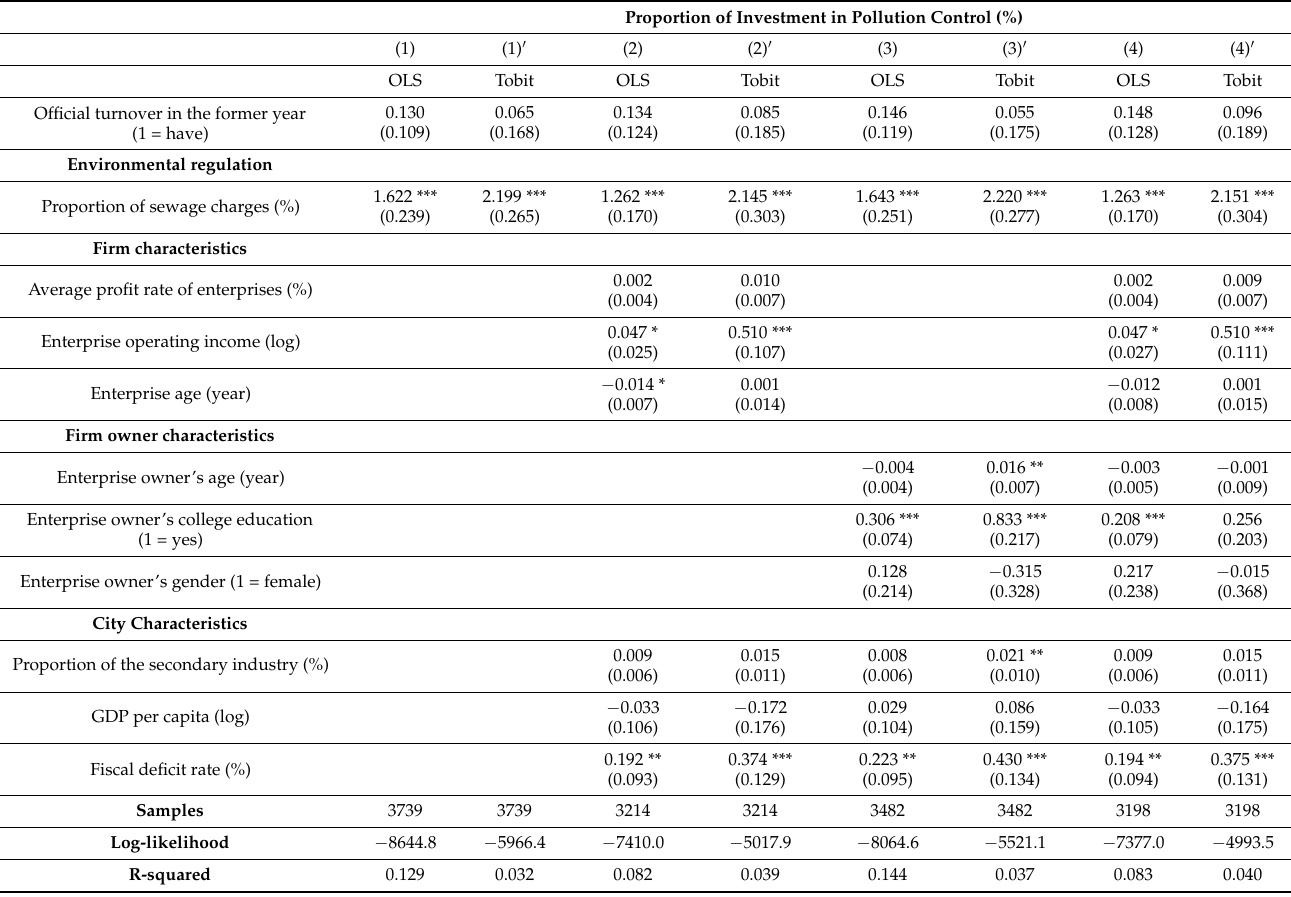
Table 3. Persistence of the effects of official